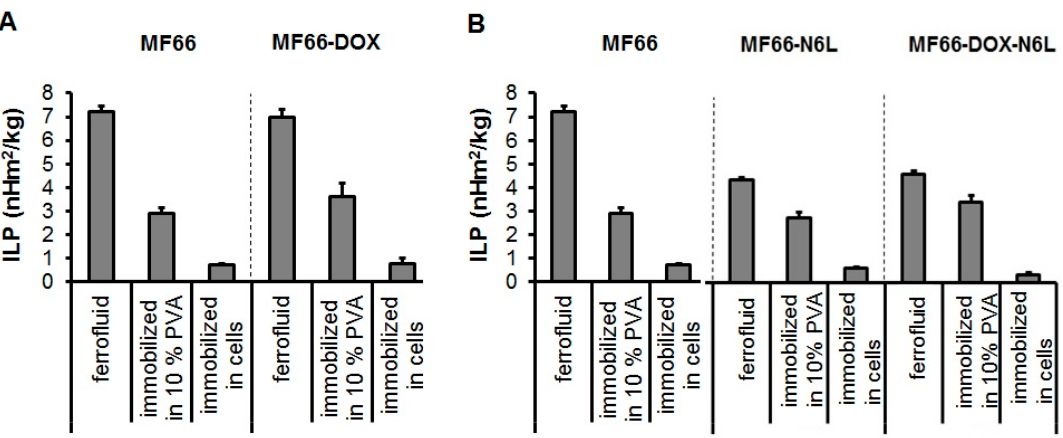
Figure 1. Characterization of the heating potential of the MF66-DOX ( A ) and the bi-functionalized MF66-DOX-N6L MNP formulations ( B ). MNPs were suspended in water or immobilized in 10% polyvinyl alcohol (PVA) as well as in BT474 cells. Mean and standard deviation of the mean of n = 3.